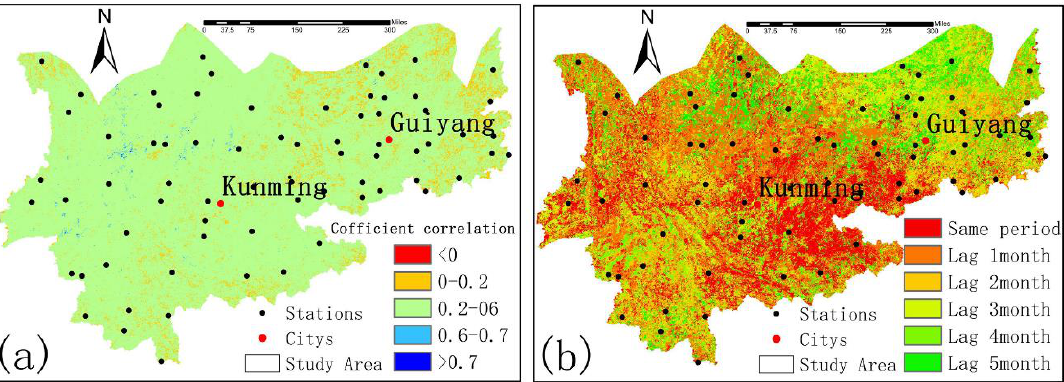
Figure 8. Spatial distribution of maximum cross-correlation ( a ) between NDVI and humidity index and time-lag response ( b ) in the Yunnan-Guizhou region. and time-lag response ( b ) in the Yunnan-Guizhou